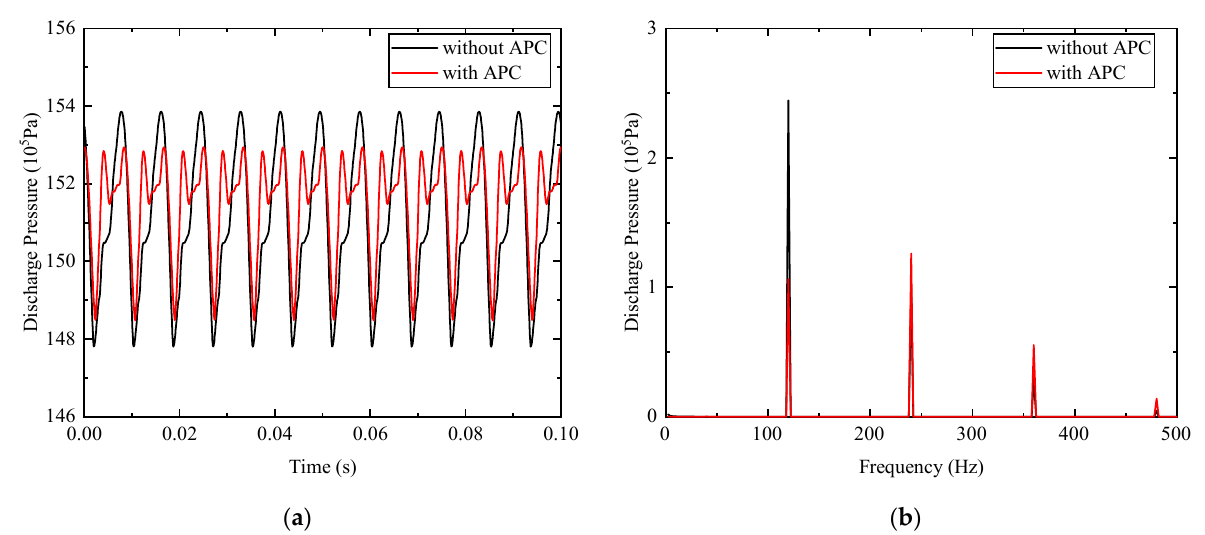
Figure 8. Comparisons of the discharge pressure with and without APC for multi-frequency components: ( a ) time-domain discharge pressure; ( b ) FFT of pressure ripple.